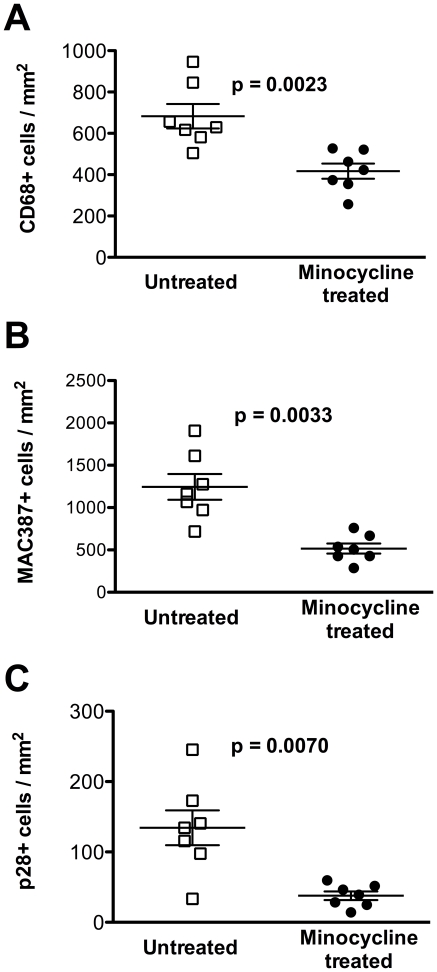
Minocycline reduces the number of CD68+, MAC387+, and p28+ cells in axillary lymph node.Quantitative analysis of CD68+ revealed significantly fewer CD68+ cells in the axillary lymph node of animals that received minocycline as compared to untreated controls (A; p = 0.0023); fewer numbers of newly infiltrating MAC387+monocytes/macrophages (B; p = 0.0033); and a decreased number of productively SIV infected p28+ cells (C; p = 0.0070). Numbers are representative of the means from a minimum of twelve fields calculated to represent a single data point for each animal. Horizontal bars indicate group mean values and error bars indicate the standard error of the mean. P values were determined using a Mann-Whitney U test.